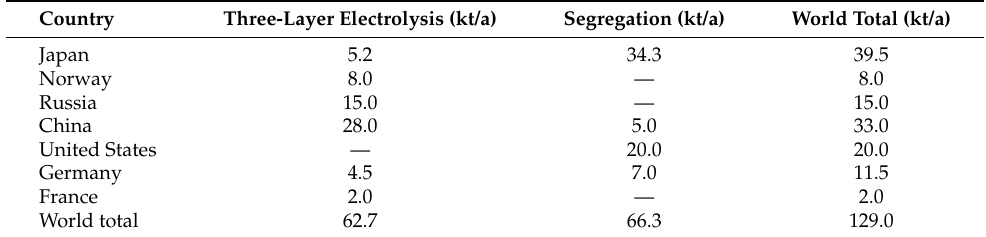
Table 2. The production capacity of high- and ultra-high-purity aluminum in the world in 2003.